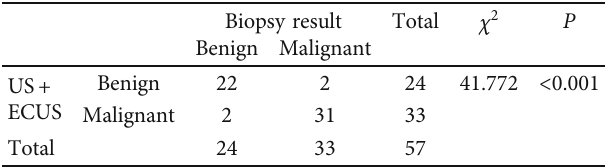
Table 6: Comparison between the results of US +ECUS and biopsy.